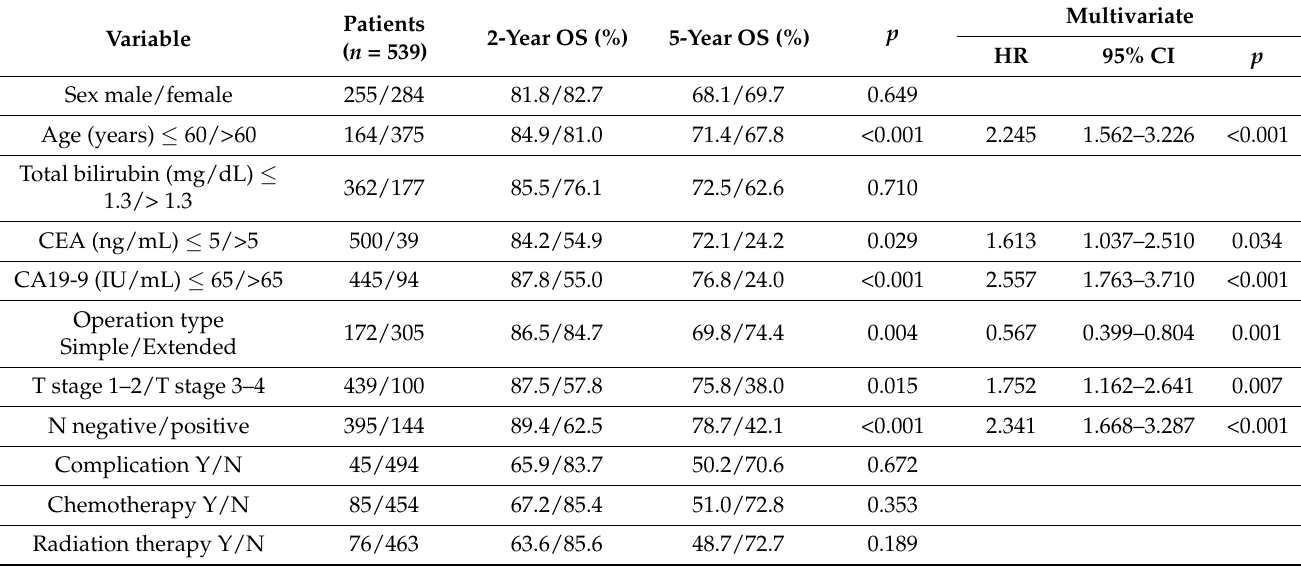
Table 2. Prognostic factors for overall survival: uni and multivariated